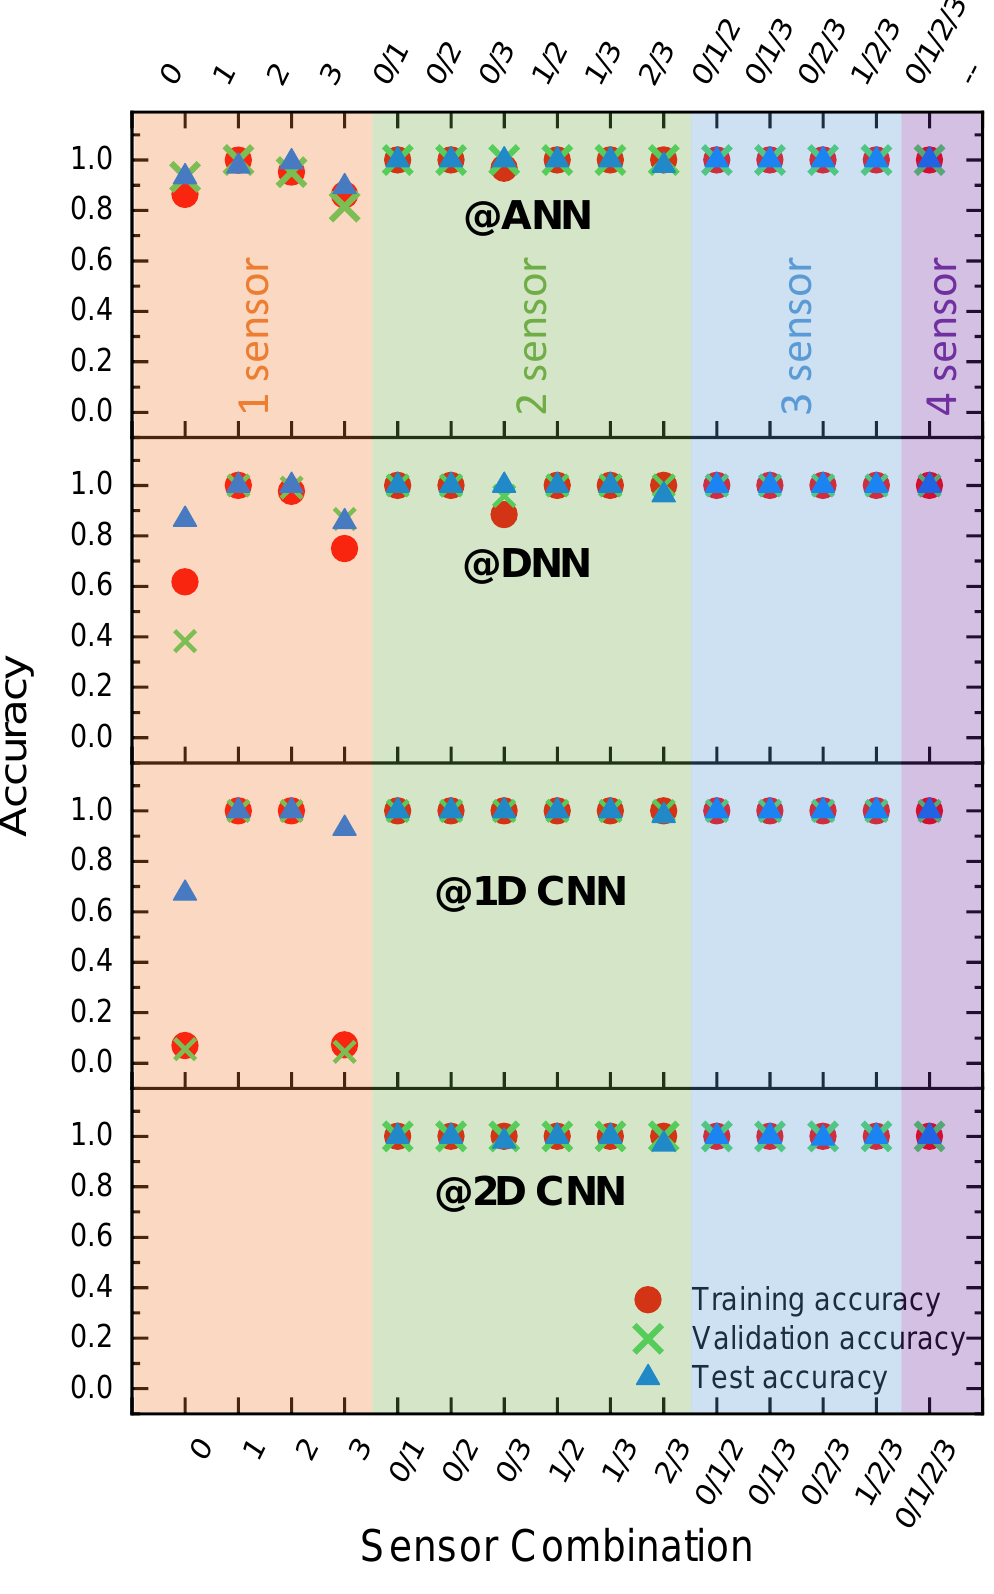
Figure 5. Accuracy information obtained as a function of the number of sensors and deep learning algorithms employed in gas detection/classification (based on the calculation at 1000 epochs): ANN (2-layer structure), DNN (4-layer structure), 1D CNN, and 2D